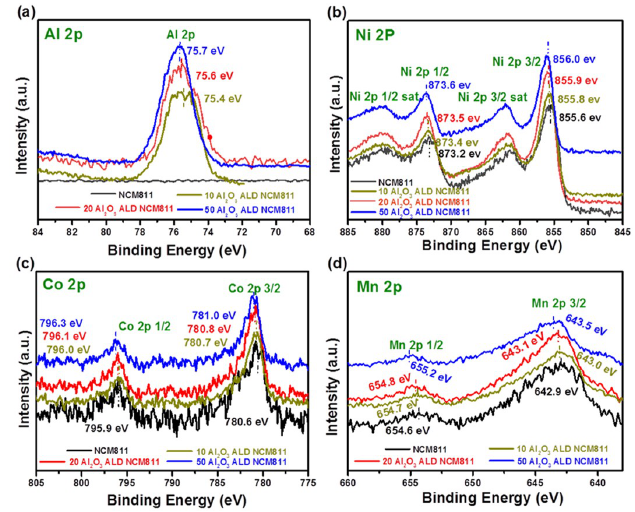
Figure 3. Characteristics XPS spectra captured on the 10 Al 2 O 3 ALD NCM811, 20 Al 2 O 3 ALD NCM811, and 50 Al 2 O 3 ALD NCM811 materials compared to the bare NCM811: ( a ) Al 2 p , ( b ) Ni 2 p , ( c ) Co 2 p , and ( d ) Mn 2 p peaks.